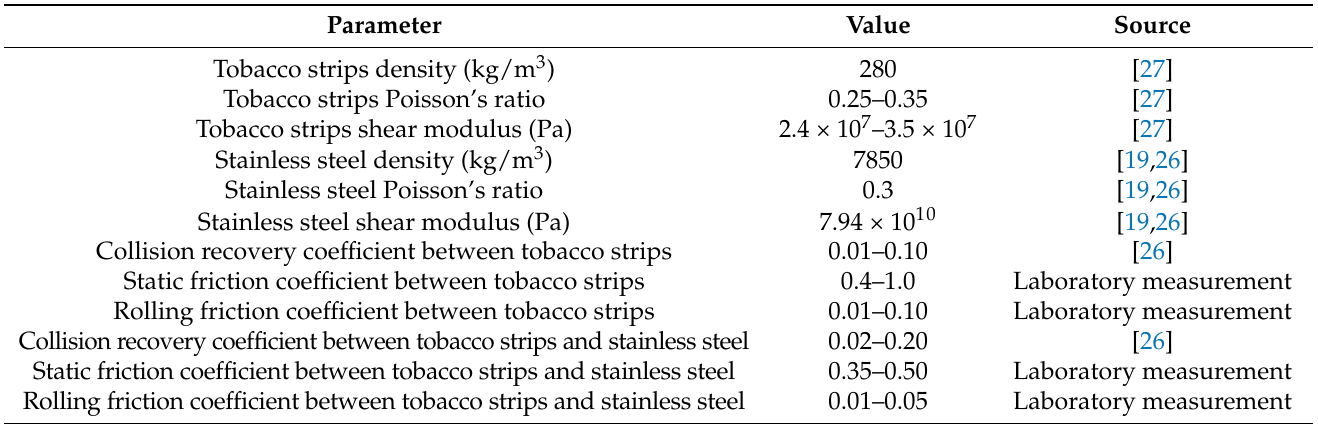
Table 3. Parameter settings for tobacco strips stacking angle simulation